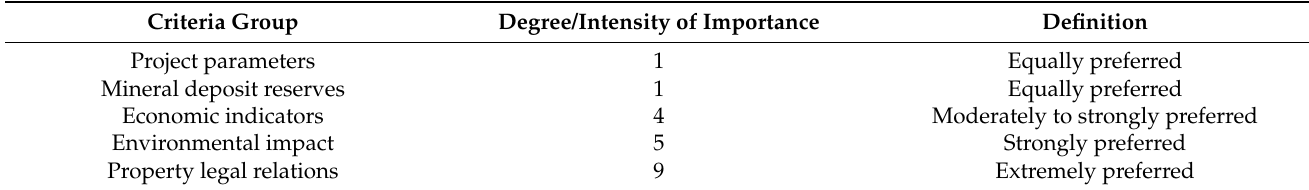
Table 3. The importance of the main group of